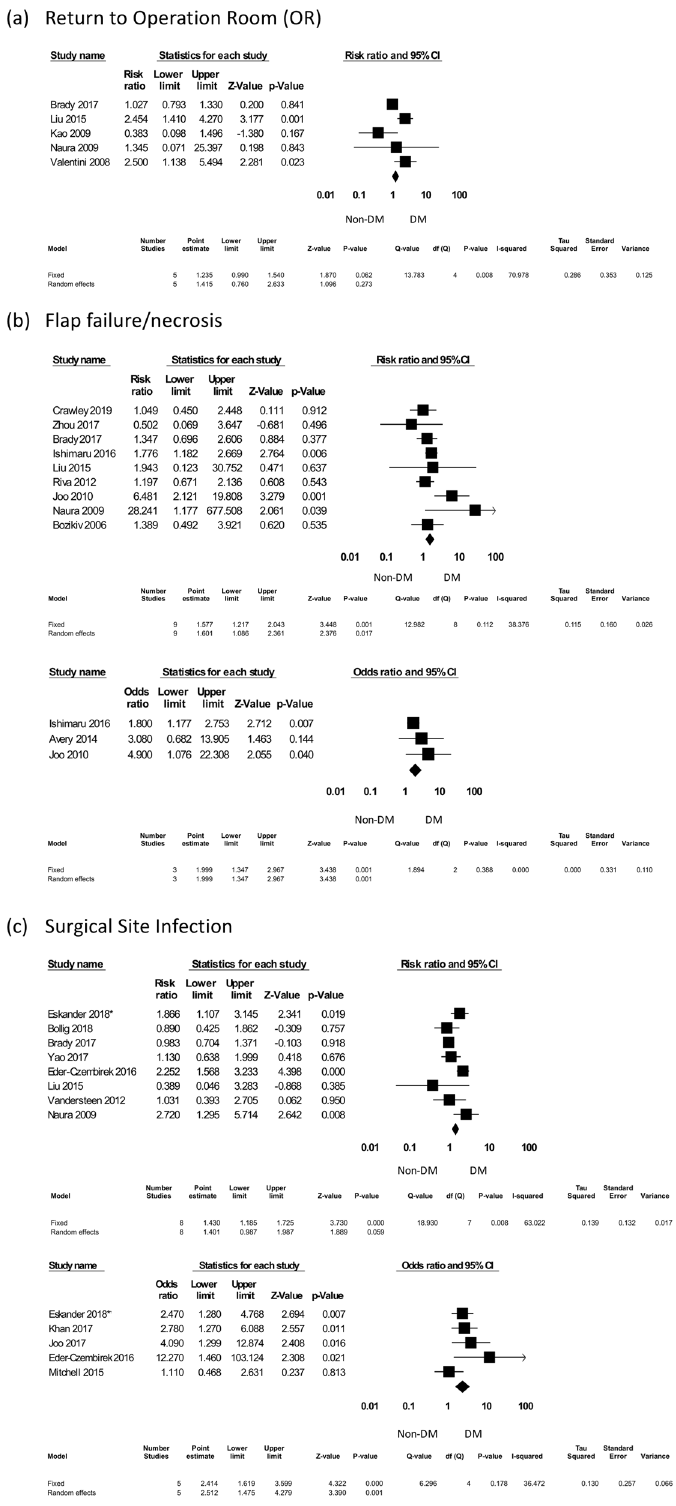
Figure 4. The individual surgical complications forest plot, part I: return to the operating room, flap failure/ necrosis, and surgical site infection. *Eskander 32